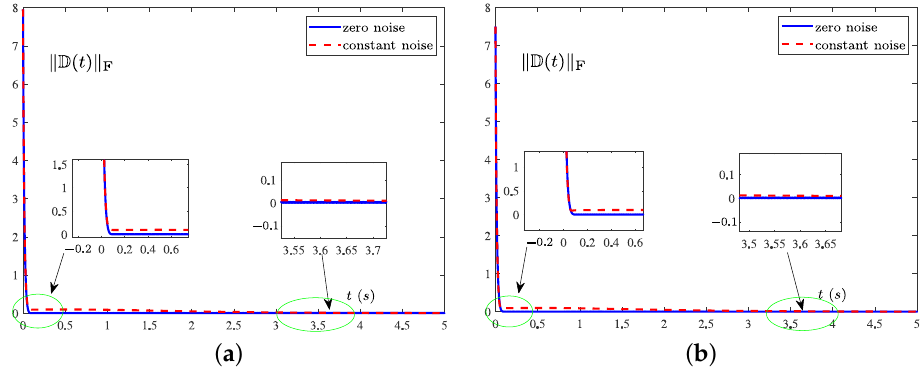
Figure 2. The estimation error (cid:107) D ( t ) (cid:107) F of Y ( t ) synthesized by the DFZNN with two activation types in different situations. ( a ) with the activation type I; ( b ) with the activation type II.